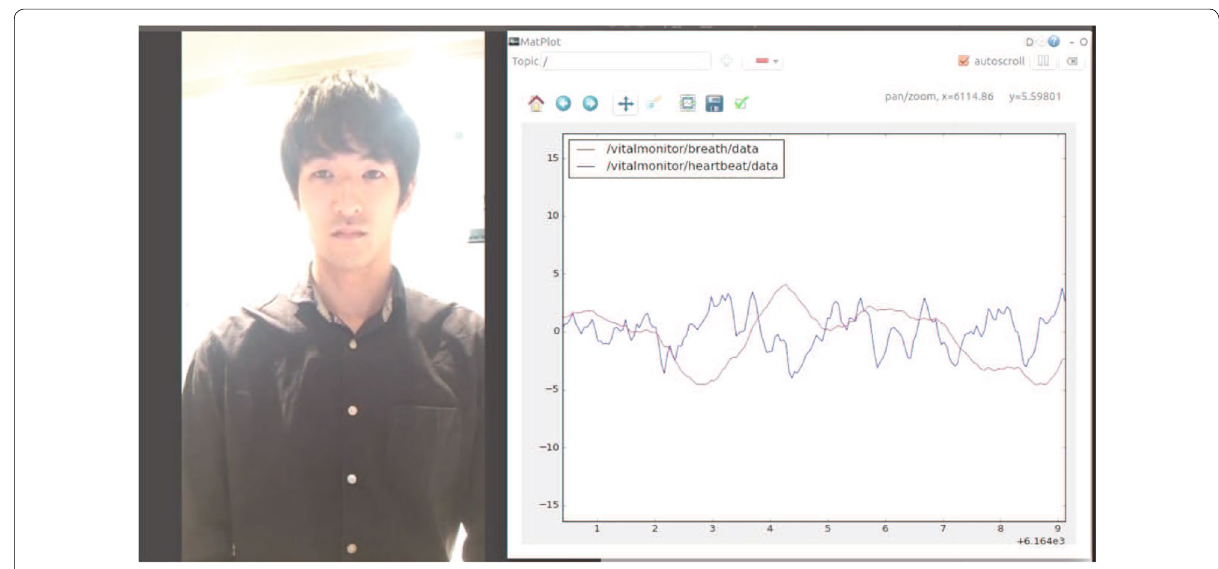
Fig. 18 Facial image and vital data displayed on remote PC